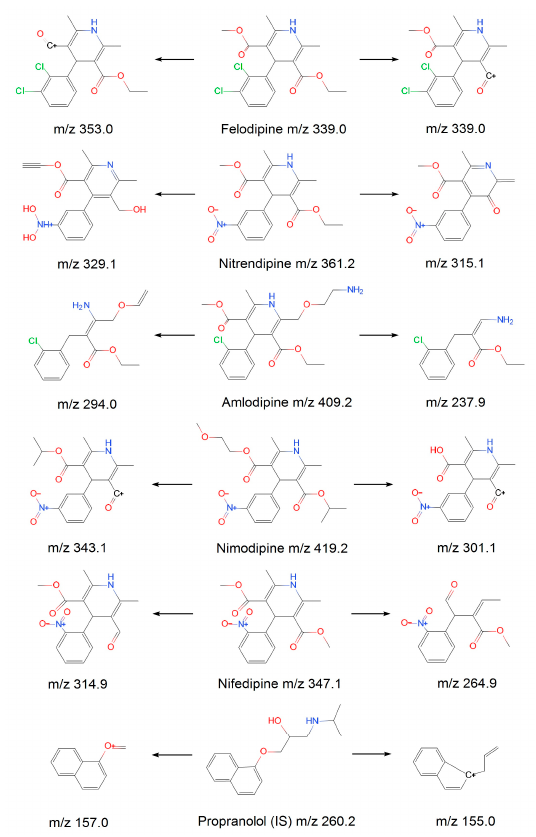
Figure 6. The chemical structure and possible fragmentation pathways of five CCBs.